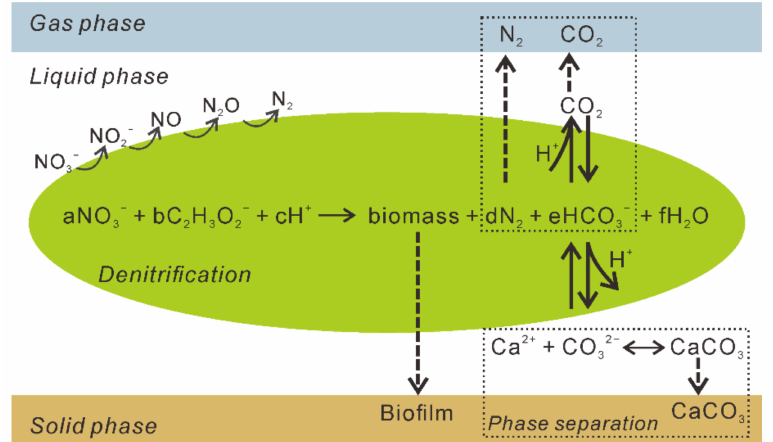
Figure 2. The complete reactions for MICP through denitrification (modified from Pham et al.